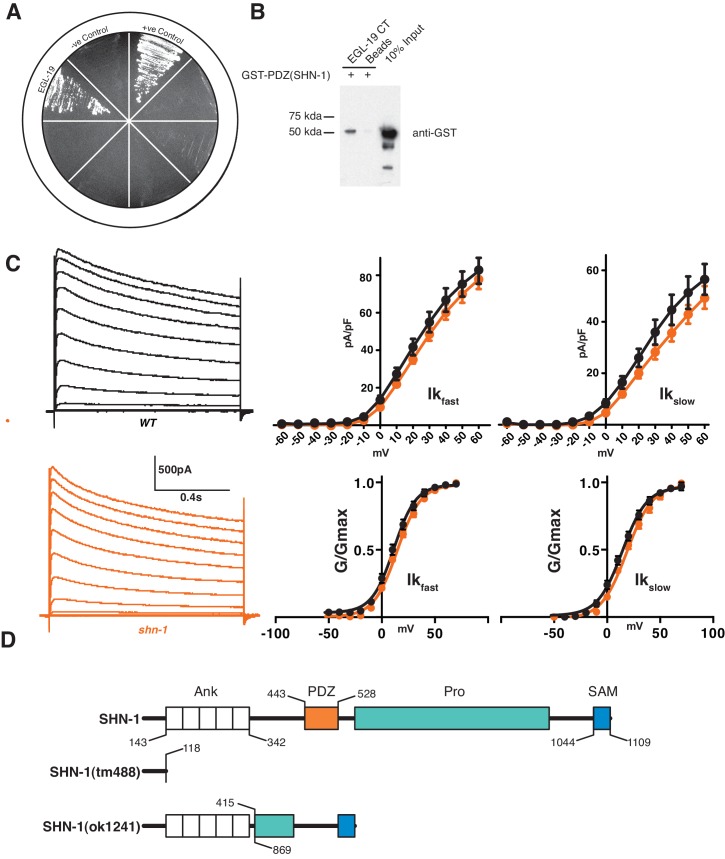
Supplemental data related to Figure 1.(A–B) The SHN-1 PDZ domain binds to the EGL-19/Cav1 c-terminus in yeast two-hybrid (A) and GST-pull down (B) assays. (C) Potassium current density and voltage-dependence of activation were unaltered in shn-1 mutants. Voltage-activated K+ currents were recorded from adult body wall muscles at holding potentials of −60 to +40 mV. Averaged traces, mean current density (pA/pF) as a function of holding potential, and normalized conductance (G/Gmax) as a function of holding potential are shown. No significant differences were observed. (D) Representation of protein domains found in SHN-1 and the predicted protein products made in the shn-1(tm488) and shn-1(ok1241) mutants. Numbers report amino acid residues for each domain and extent of deletions in the mutants. Error bars indicate SEM. Mean, standard errors, sample sizes, and p values for this figure are shown in Supplementary file 1.